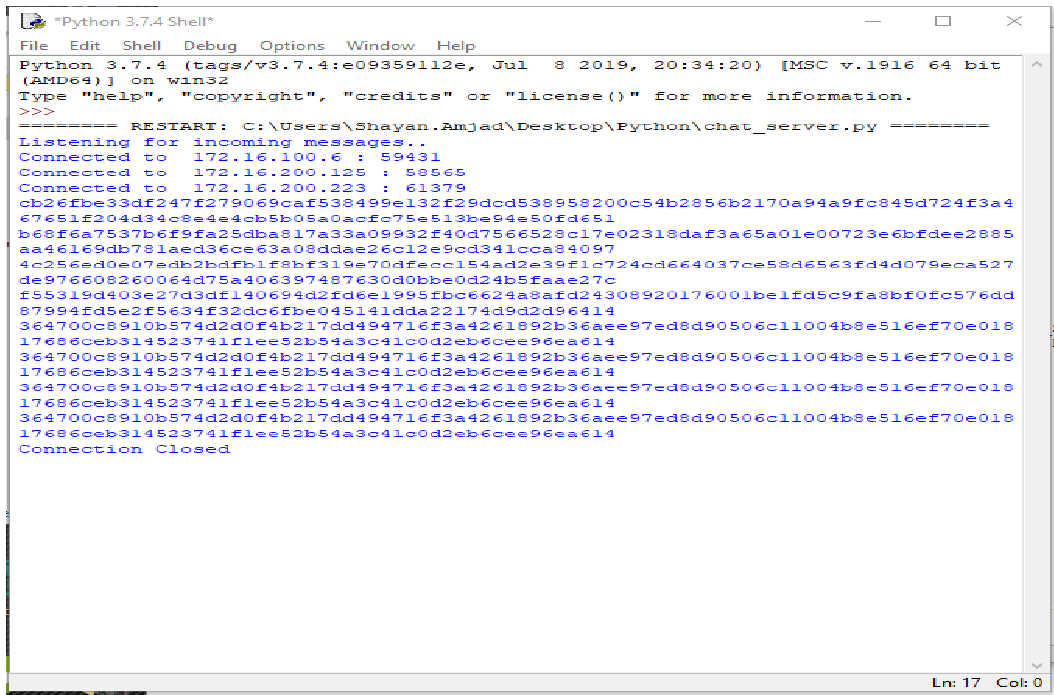
Figure 8. One node disconnected.